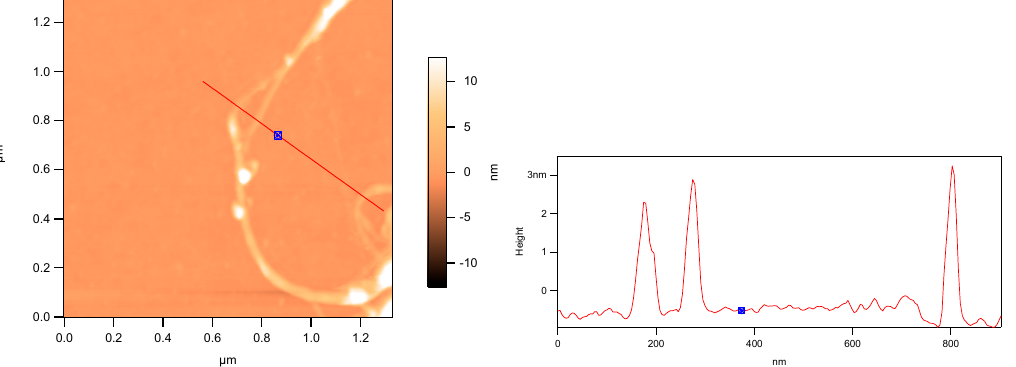
Figure 7. TEM images of SWNTs- g -PS.